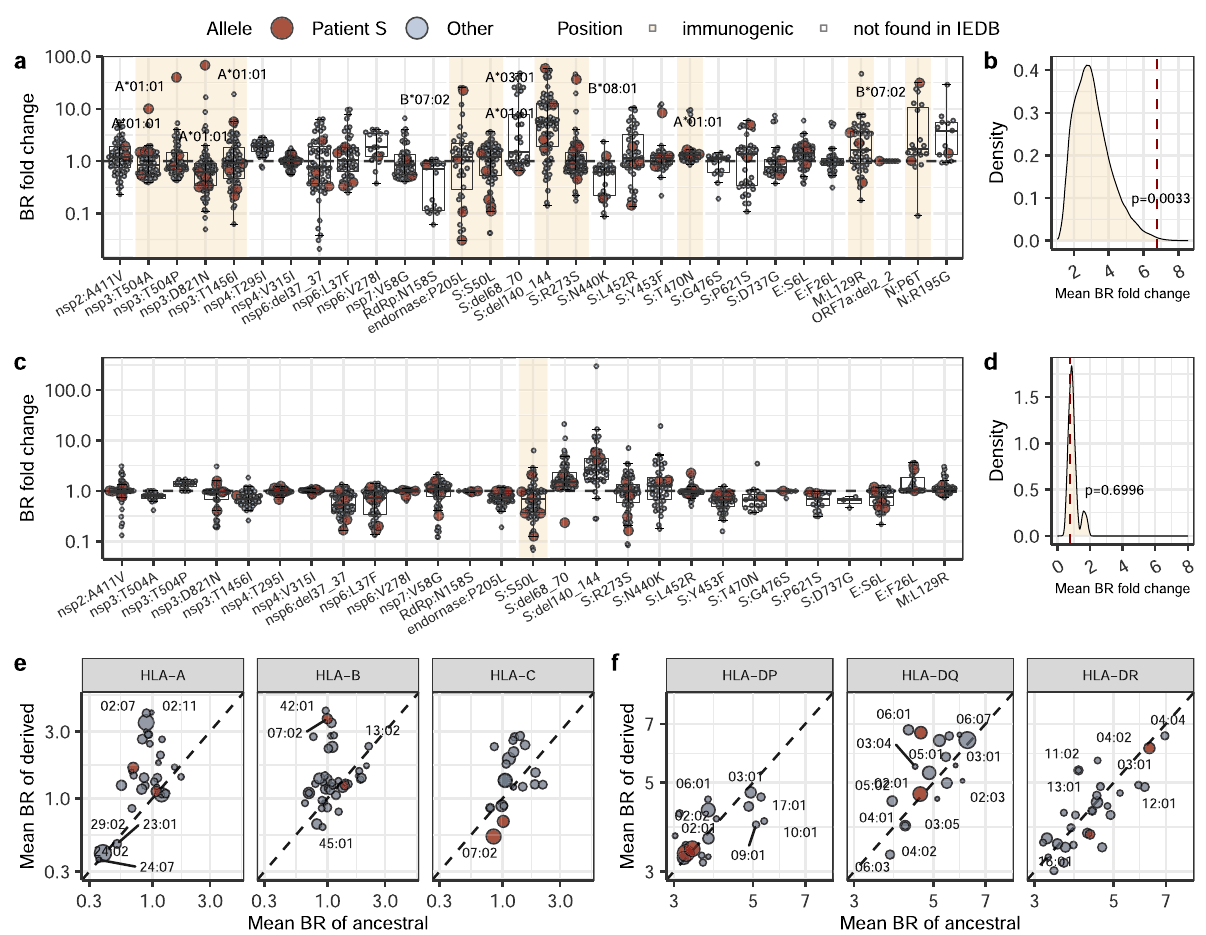
b , d DistributionofmeanBPRfoldchangesamongimmunogenicpositionsforHLA I b orII d alleles,basedon10 5 randomgenerationsofindividualallelecomposition; the red dashed line is the percentile corresponding to the allele composition of patientS.One-sidedlevelofsigni fi canceisthefollowing:p-value=0.0033for b and p -value=0.6996 for d ; e , f The sum effect of the amino acid changing mutations observed in SARS-CoV-2 of patient S on antigen presentation by the globally most frequentHLAclassI e andclassII f .TheallelesofpatientSareinred.Sourcedataare provided as a Source Data fi